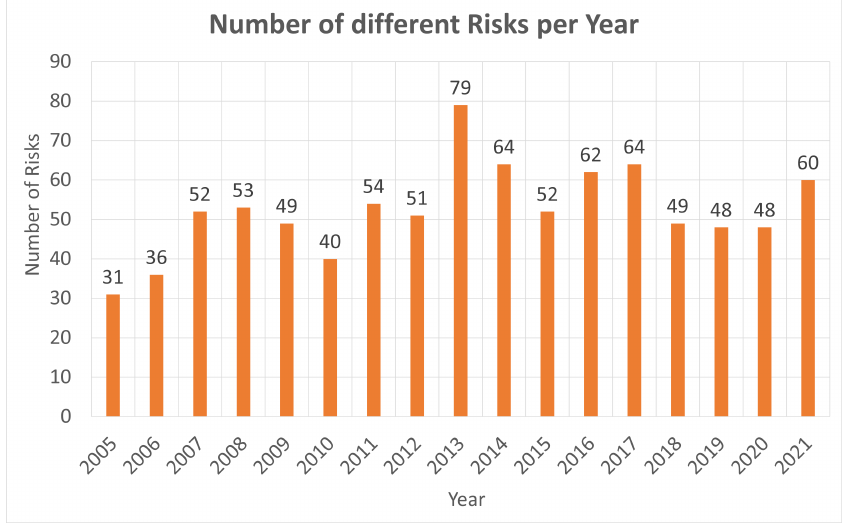
Figure 4. Number of unique risks per year. When at least one keyword from the causes of a specific risk is found in a report from a particular year, this risk is accounted for in the unique risks per year shown in this graph. It is important to note that if keywords were found on different reports for the same risk, that risk was counted only once for that particular